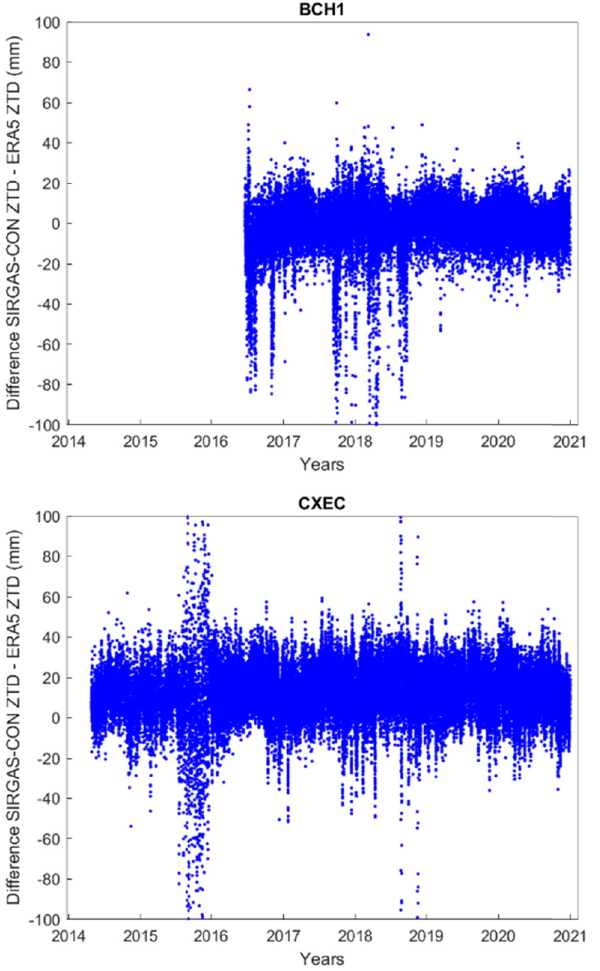
Figure 9: SIRGAS - CON ZTD and ERA5 ZTD di ff erences for stations ( a ) AUTF and ( b )